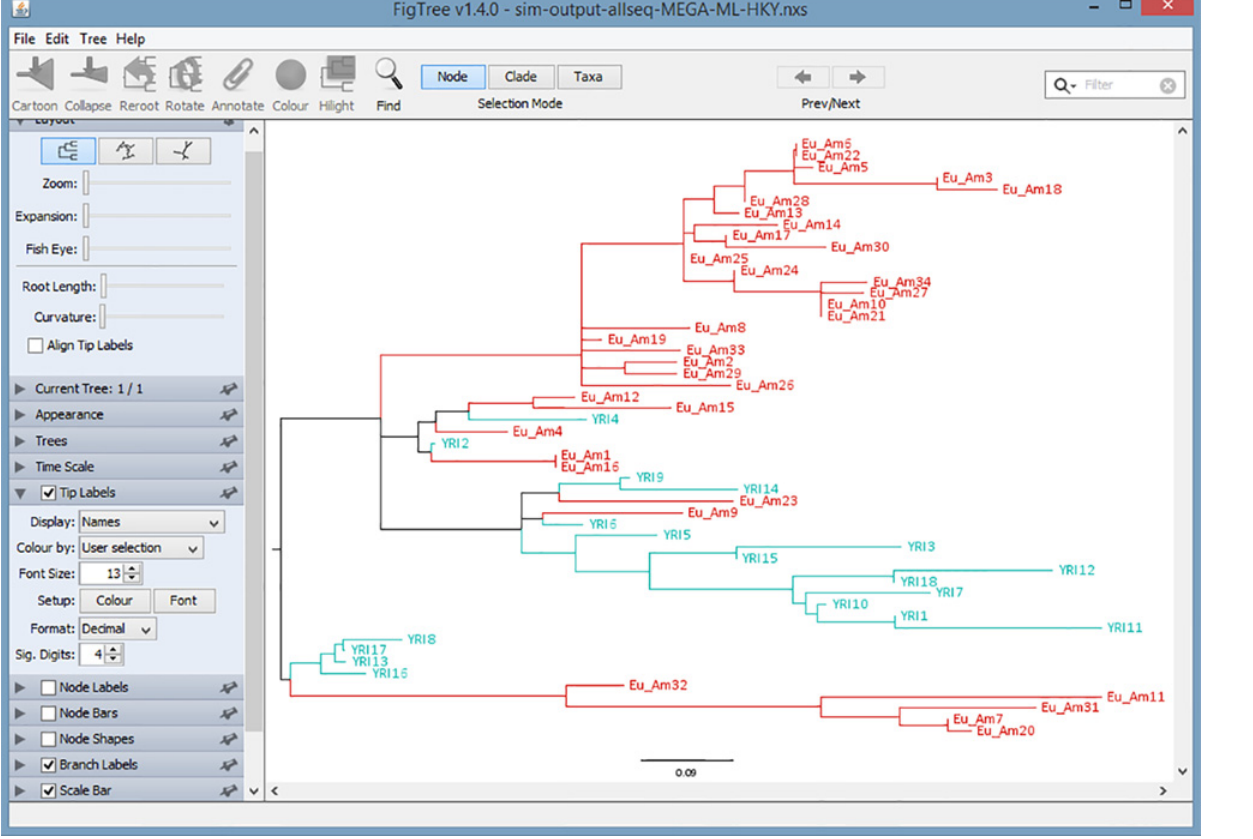
Fig 7. The Tree Resulting from using external files generated by MEGA